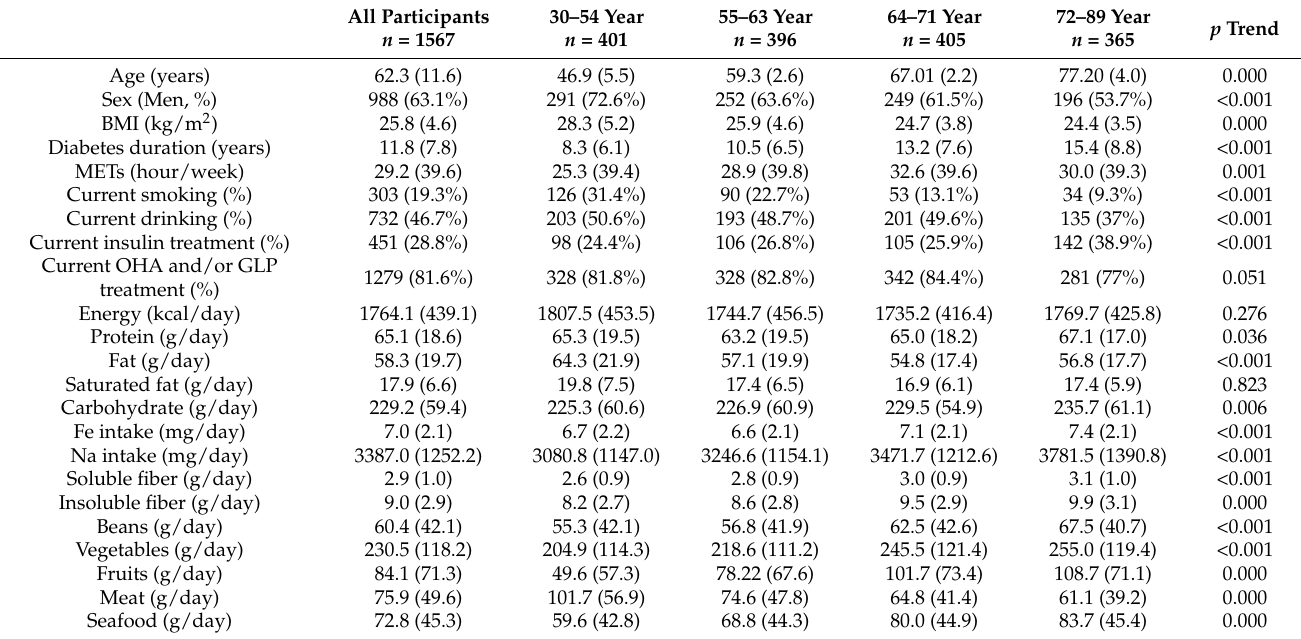
Table 1. Participants’ characteristics according to quartiles of age